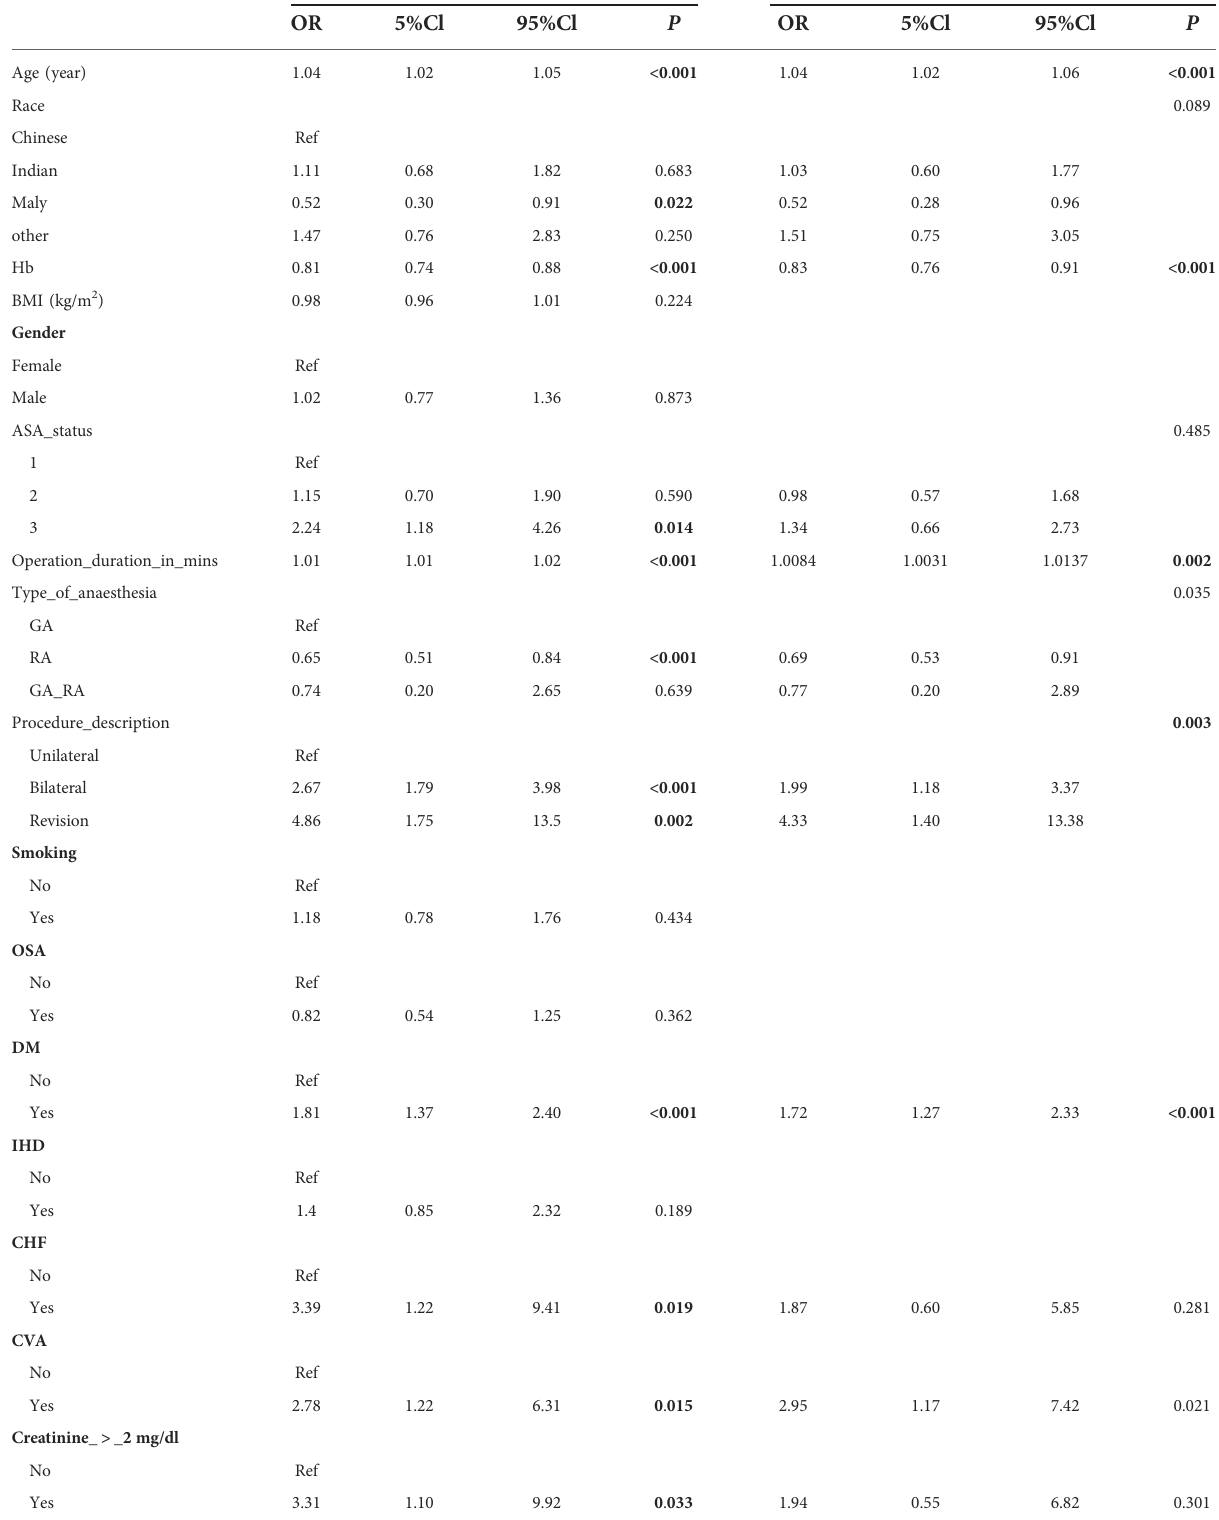
TABLE 3 Univariate and multivariate analysis of prolonged hospital stay in undergoing TKA